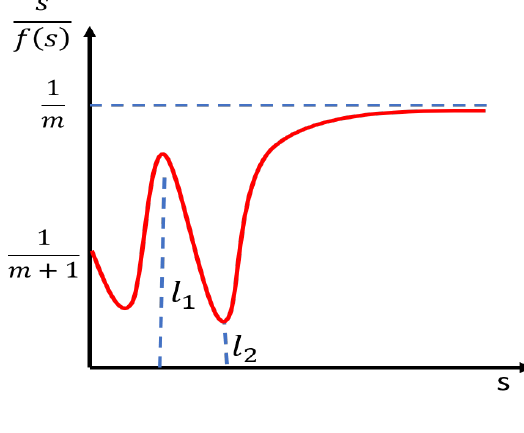
when our hypotheses are Fig. 1: Shape of s f ( s )